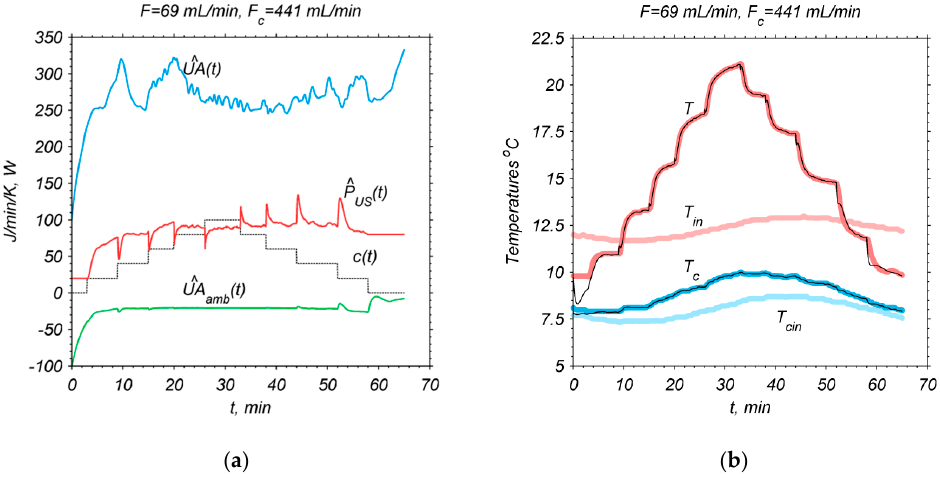
Figure 5. Experimental results for F = 69 mL / min: ( a ) estimates of unknown model parameters ˆ θ ( t ) = ˆ P ( t ) U ˆ A ( t ) U ˆ A ( t ) ; ( b ) measured temperatures (thick red and blue lines) and model predictions (black lines) for ˆ θ ( t ) .